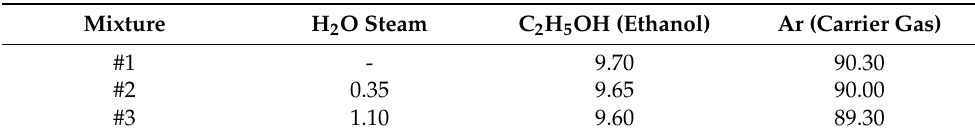
Table 1. Composition of reaction mixtures used in the tests of thermocatalytic ethanol decomposition